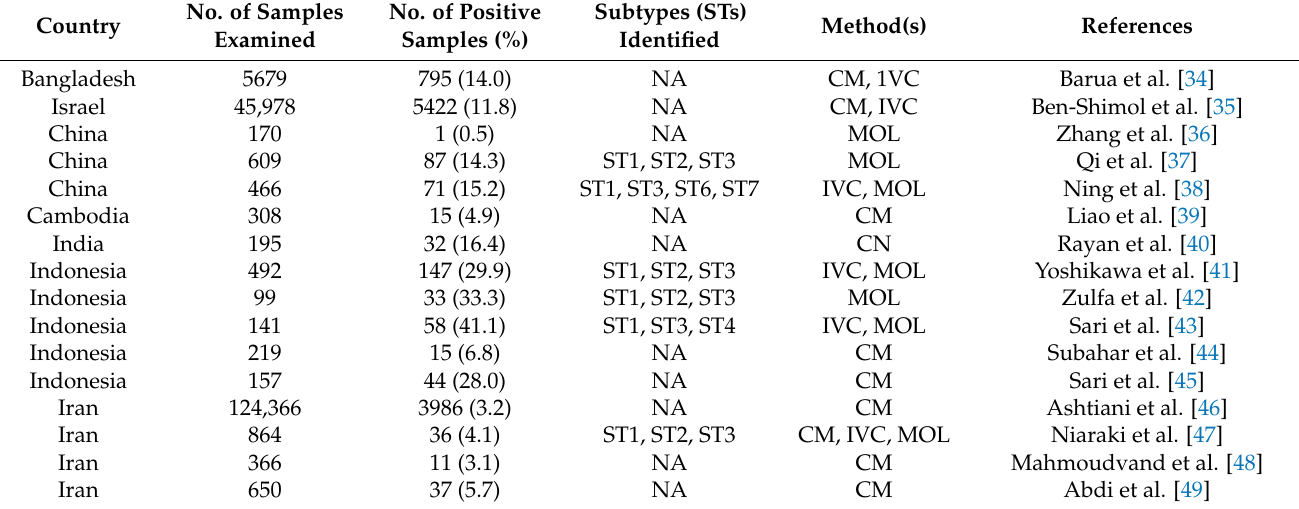
Table 1. Prevalence and subtype distribution of Blastocystis spp. in children in Asia